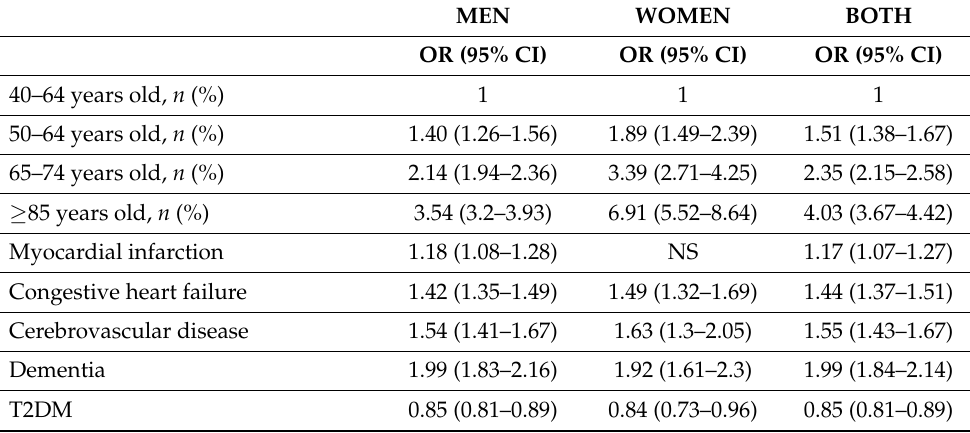
Table 5. Multivariable analysis to assess time trend and to identify study variables independently associated with in-hospital mortality among men and women hospitalized with CAP in Spain from 2016 to